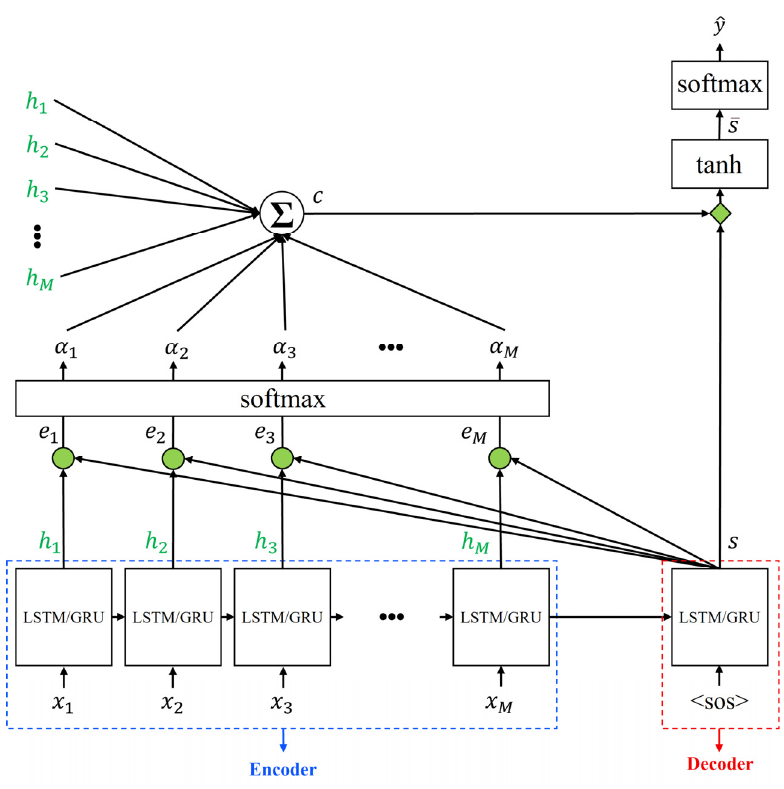
Figure 7. Architecture of LSTM and GRU with the attention mechanism.